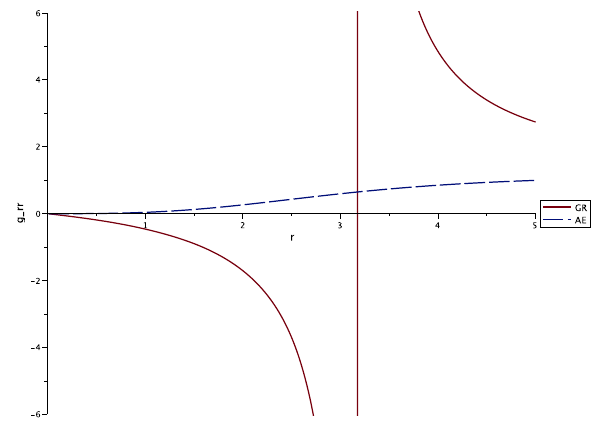
Fig. 7 Plot of the metric component g rr , for EA parameters c 14 = − 16, | κ | = 1 and an arbitrary Schwarzschild mass M = 32 1 3 / 2. The continuousredlinerepresentstheGRSchwarzschildmetric.Thedashed blue line represents the EA solution. Calculating the limit r → +∞ we obtain g rr = e 2 B → 1, as we can see in this figure. Calculating the limit r → r sing 1 = 0 we obtain g rr = e 2 B → 0, as we can see in this